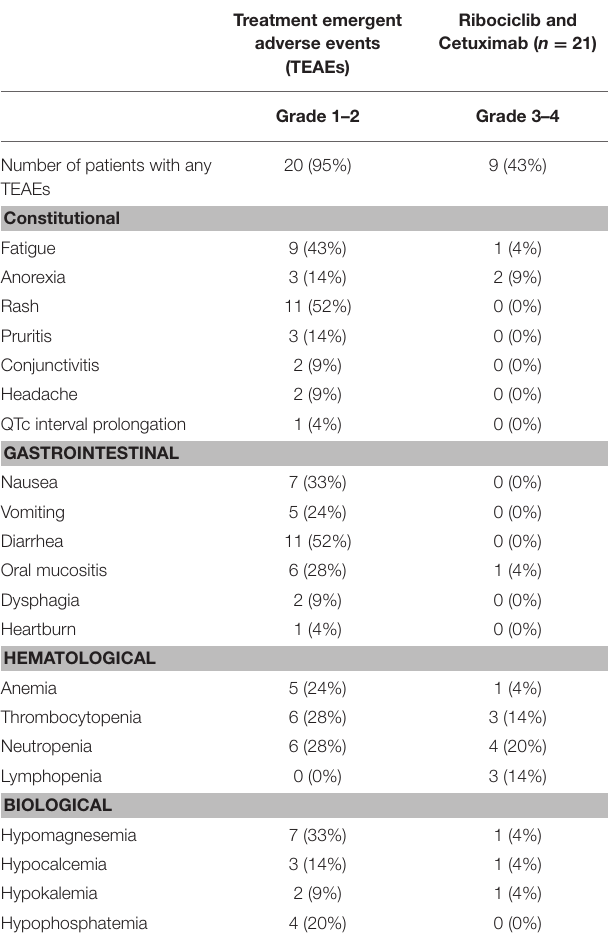
TABLE 1 | Patient characteristics. TABLE 2 | Treatment emergent adverse events (NCI-CTC version